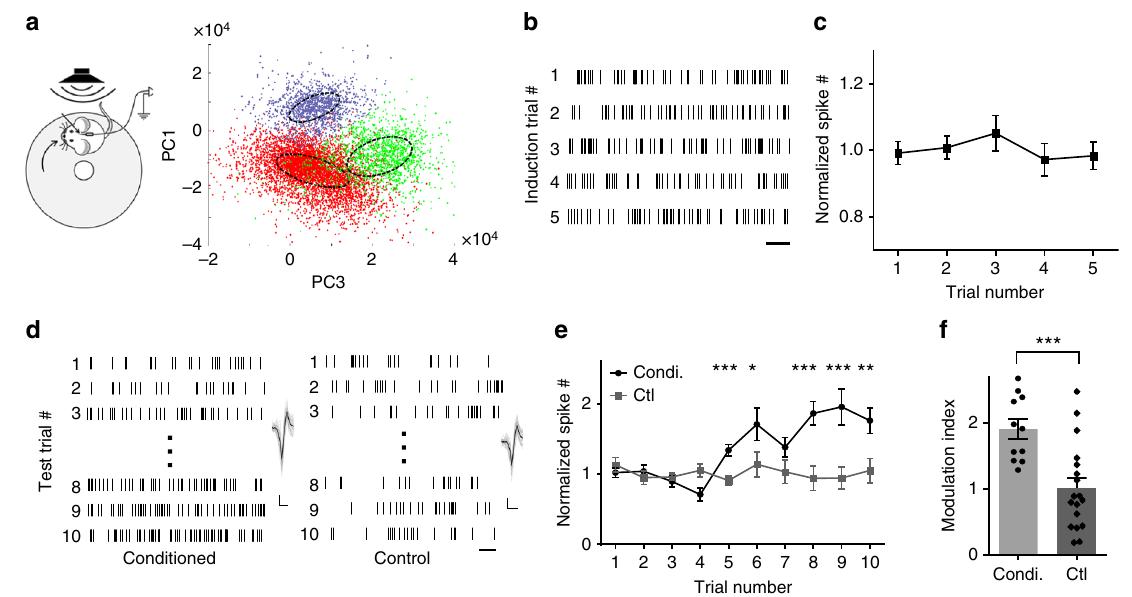
Fig. 5 ZIr activities during fear conditioning and fear extinction. a Left, experimental setup for extracellular recording. Right, principal component analysis for an example recording session. The graph shows the projection of principal components to the PC1 – PC3 plane. Colors mark different clusters of the spikes. Dashed circles denote the boundary of well separated spikes. b Raster plot of spikes for an example ZIr unit during CS presentation (19 s, just before the foot shock). Scale: 2 s. c Average normalized spike rate of ZIr units during fear induction, n = 12 units from four animals. d Raster plot of spikes for example units during the fi rst and last three presentations of CS alone in an example conditioned and non-conditioned control mouse respectively. Scale: 0.5 s. Inset, superimposed 50 individual spikes and their average (black) for the corresponding unit. Scale: 20 µ V, 0.5 ms. e Average normalized spike rate of ZIr units at each CS presentation in conditioned (black, n = 11 units from six animals) and control (gray, n = 18 units from six animals) mice. *** p (trial5) < 0.001, * p (trial6) = 0.031, *** p (trial8) = 0.003, *** p (trial9) < 0.001, ** p (trial10) = 0.006, two-sided Mann – Whitney U test. f Modulation index calculated for each unit for the conditioned and control groups. *** p < 0.001, two-sided unpaired t -test. Solid symbol represents mean ± s.e.m. for all